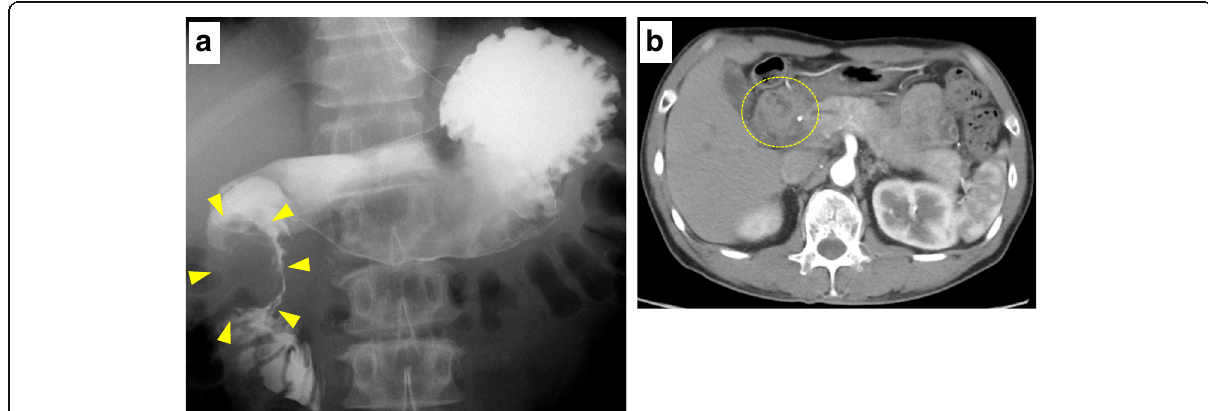
Fig. 2 a Upper gastrointestinal series demonstrated a filling defect in the duodenum, while the inside of the cystic lesion was not contrasted. b Follow-up CT on the 27th day after TAE showed that the cyst decreased in